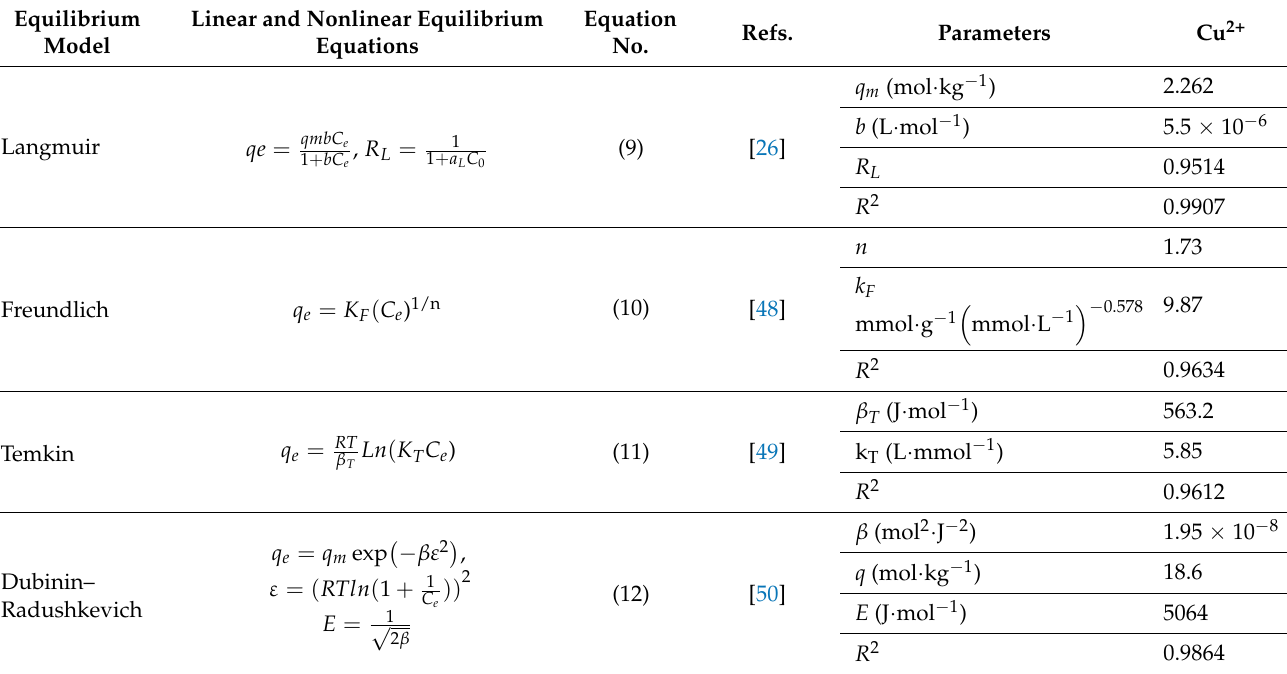
Table 2. Different equilibrium isotherms’ constants for Cu 2+ ion adsorption by Zr-G-C 3 N 4 nanomaterial. Equilibrium Linear and Nonlinear Model